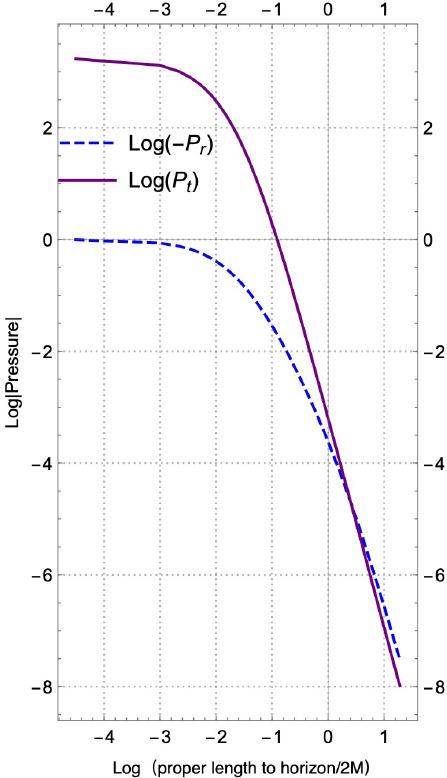
. Radial pressure (dashed line) 1 + a